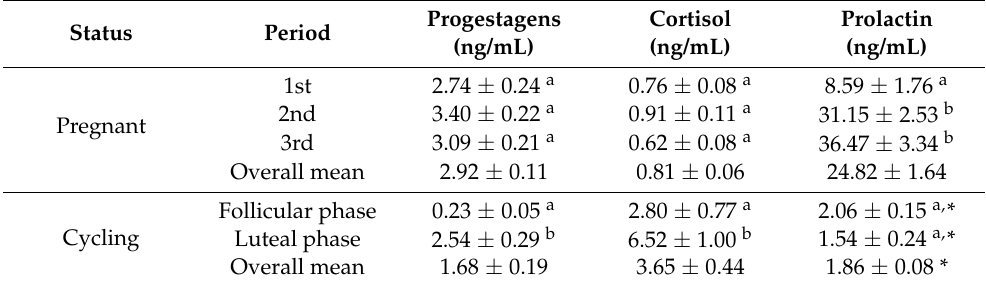
Table 2. Mean ( ± SEM) serum progestagens, cortisol, and prolactin concentrations (ng/mL) across different phases of the estrous cycle and period of pregnancy. Progestagens Cortisol Status Period (ng/mL)